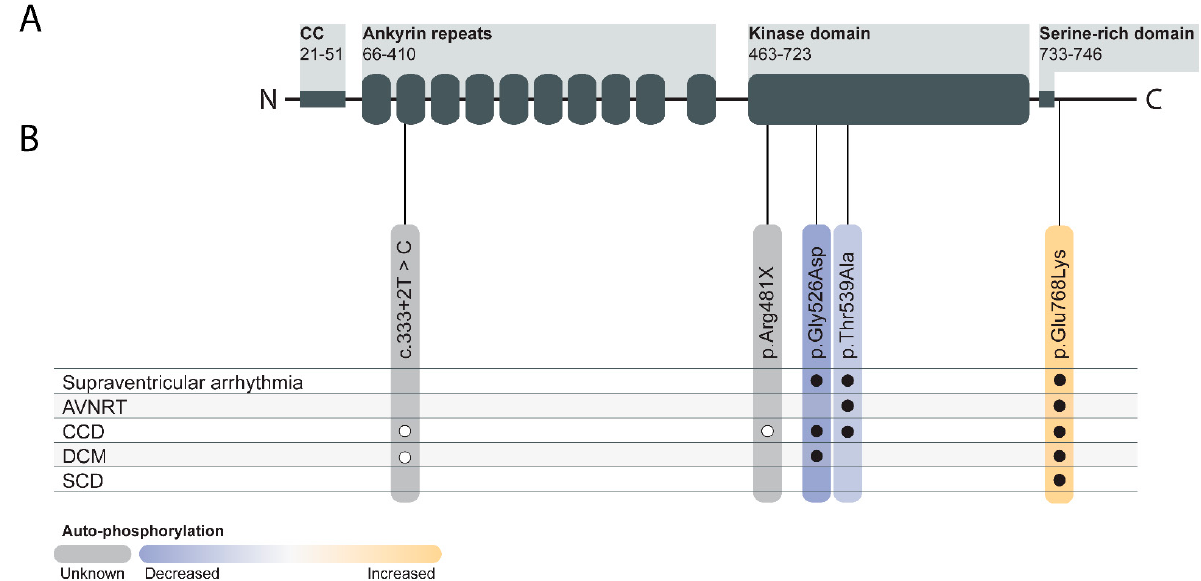
Figure 1. Schematic TNNI3K protein structure and the distribution of genetic variants. ( A ) Schematic TNNI3K protein from the N-terminus to the C-terminus containing a coiled-coil (CC) domain, ankyrin repeats, a kinase domain, and a serine-rich domain. The numbers represent the amino acid location. ( B ) Distribution of TNNI3K variants associated with cardiac diseases and changes in auto-phosphorylation. The color indicates the level of auto-phosphorylation (see color legend). Open circles: phenotypes described with variants of unknown significance; closed circles: phenotypes in families with significant genetic evidence for association with disease. AVNRT: atrioventricular nodal re-entrant tachycardia; CCD: cardiac conduction disease; DCM: dilated cardiomyopathy; SCD: sudden cardiac death.